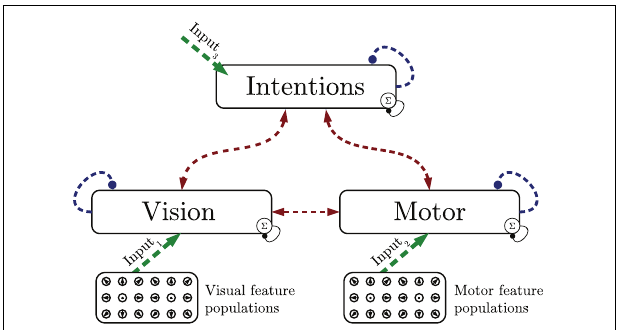
FIGURE 4 | Experiment 1: state segmentation and learning . Dashed lines indicate the learning of prototype states and temporal predictions. During learning, all information is assumed to be available, sensory signals are fully trusted.